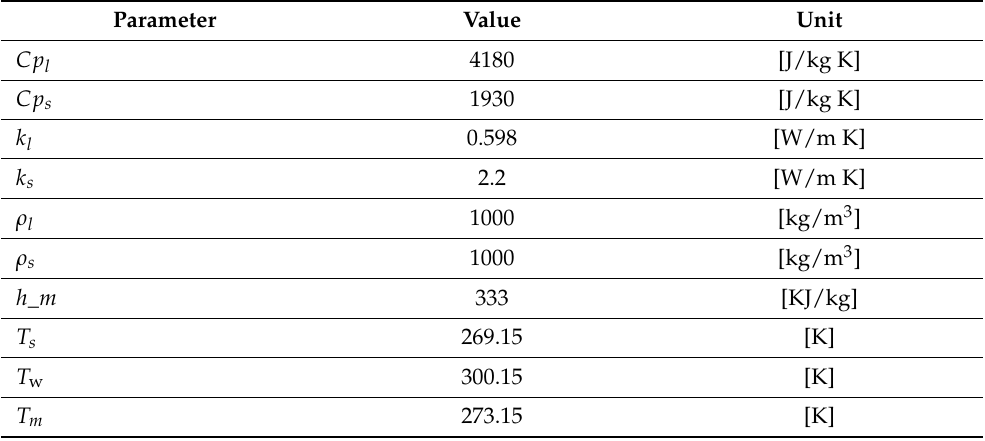
Table 1. Test case